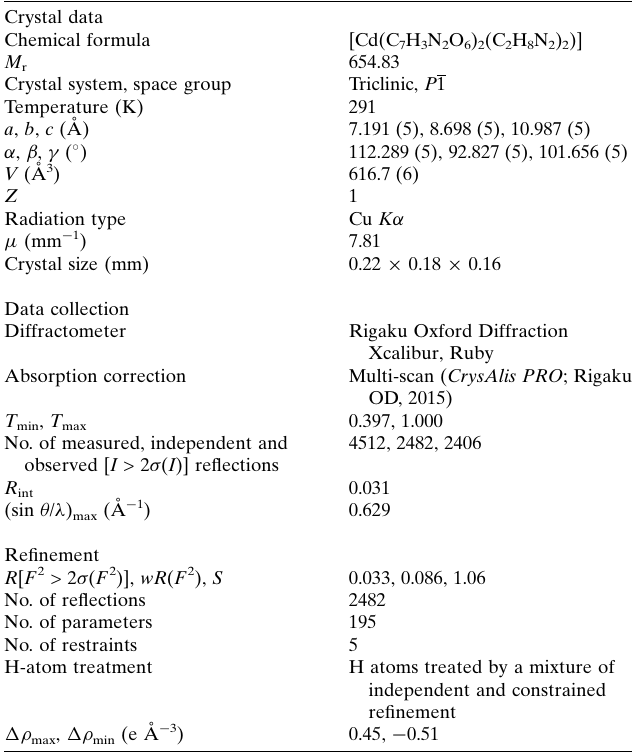
Table 2 Experimental details. Crystal data Chemical formula